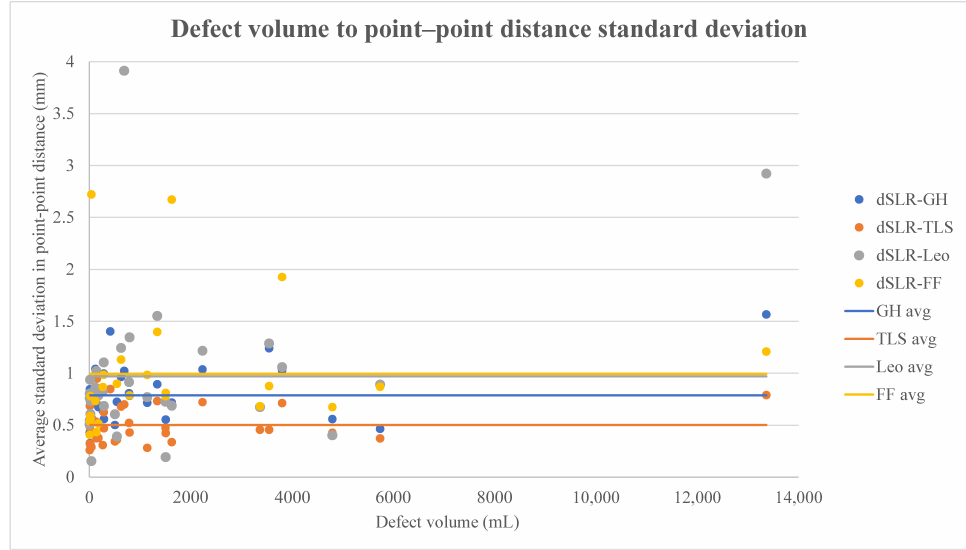
Figure 10. Correlation between defect size and standard deviation in point–point distances.